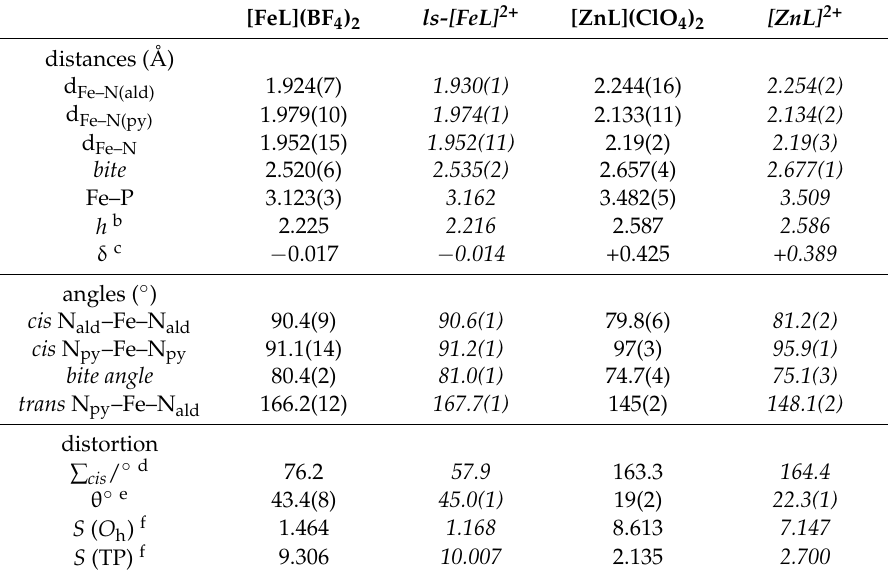
Table 2. Pertinent geometric parameters ((average) bond lengths in Å; angles in ◦ ; standard deviations in parentheses) of the complexes [FeL] 2+ and [ZnL] 2+ from XRD analysis and DFT calculations (italicized).